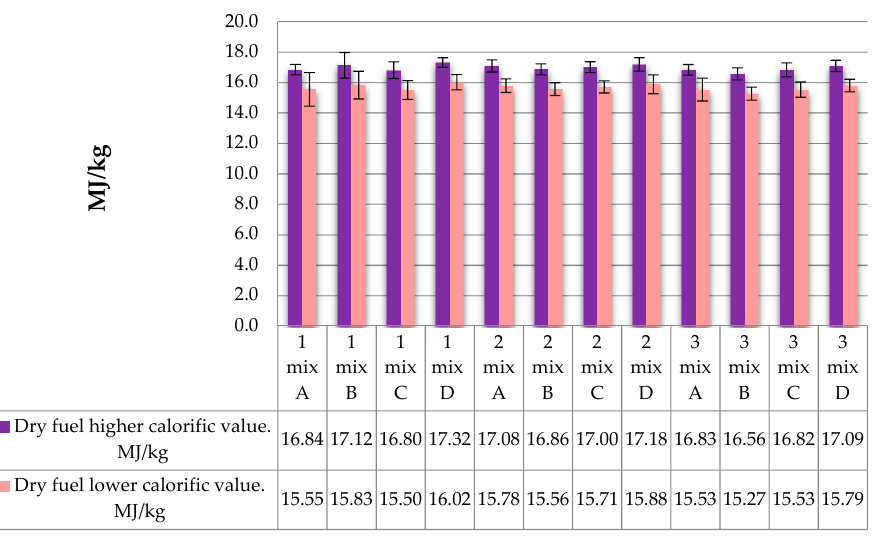
Figure 3. Calorific value of faba bean and potato peel pellets (proportions of potato and beans: 1:1 (A); 1:2 (B); 1:3 (C); 1:4 (D) by volume).